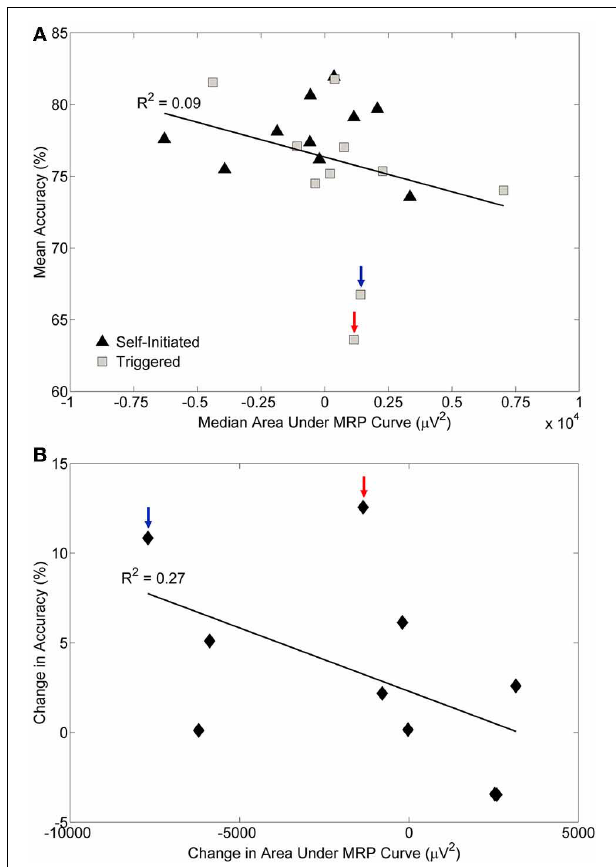
FIGURE 9 | Relationship between pre-movement decoding accuracy and the movement related potential (MRP). (A) The median area under the MRP curve plotted against the mean decoding accuracy for each subject and condition. A negative value of MRP area under the curve indicates the presence of larger MRPs. The coefficient of determination (R 2 ) is indicated. (B) The change in decoding accuracy across conditions plotted against the change in area under the MRP curve for each subject. A large negative value for change in area indicates a stronger MRP presence during the self-initiated condition, while a large positive value indicates a stronger MRP presence during the triggered condition; values close to zero indicate similar MRPs for both conditions. The coefficient of determination (R 2 ) is indicated. The two participants with the largest difference in accuracy across conditions are indicated by the